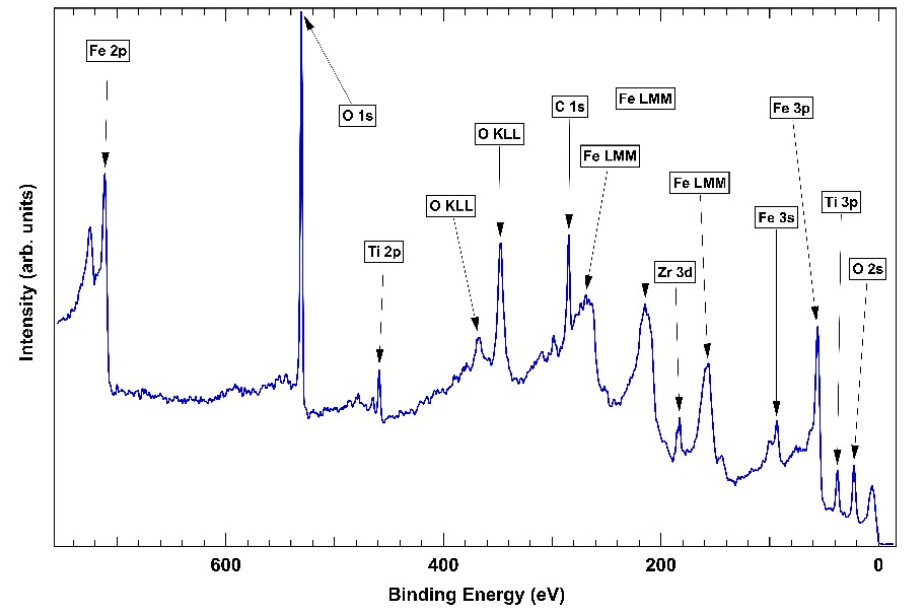
Figure 1. Survey spectrum of as-cast TiFe + 4 wt.% Zr.